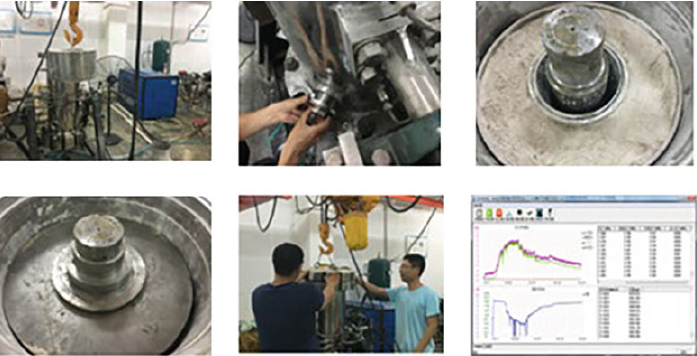
Figure 7: Experimental fl owchart.